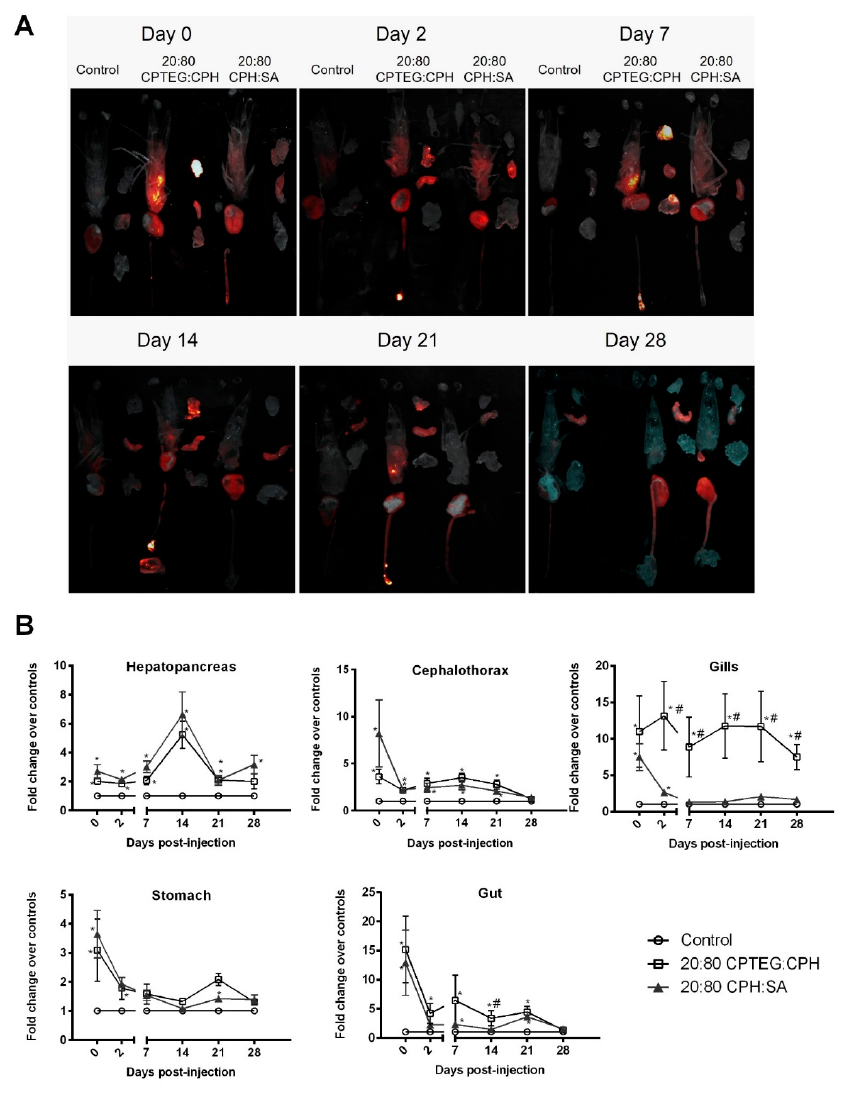
Figure 4. Biodistribution of 1% rhodamine-loaded nanoparticles in L. vannamei post-RG administration. Shrimp were injected with 250 µg of either 20:80 CPTEG:CPH or 20:80 CPH:SA rhodamine-loaded nanoparticles by reverse gavage (RG). At indicated time intervals, animals were dissected into cephalothorax, hepatopancreas, gut, gills, and stomach. ( A ) Qualitative image analysis. Tissue samples were placed on an imaging tray and rhodamine fluorescence was captured using Carestream Multispectral Imager. Images shown are representative of results obtained from two independent experiments. ( B ) In vivo fluorescence quantification of rhodamine. Data are expressed as the mean fold change over controls ± SEM of two independent experiments. Statistical differences ( p < 0.05) of either nanoparticle treatment in comparison to the control are indicated by *, while differences between the two nanoparticle formulations are indicated by #.